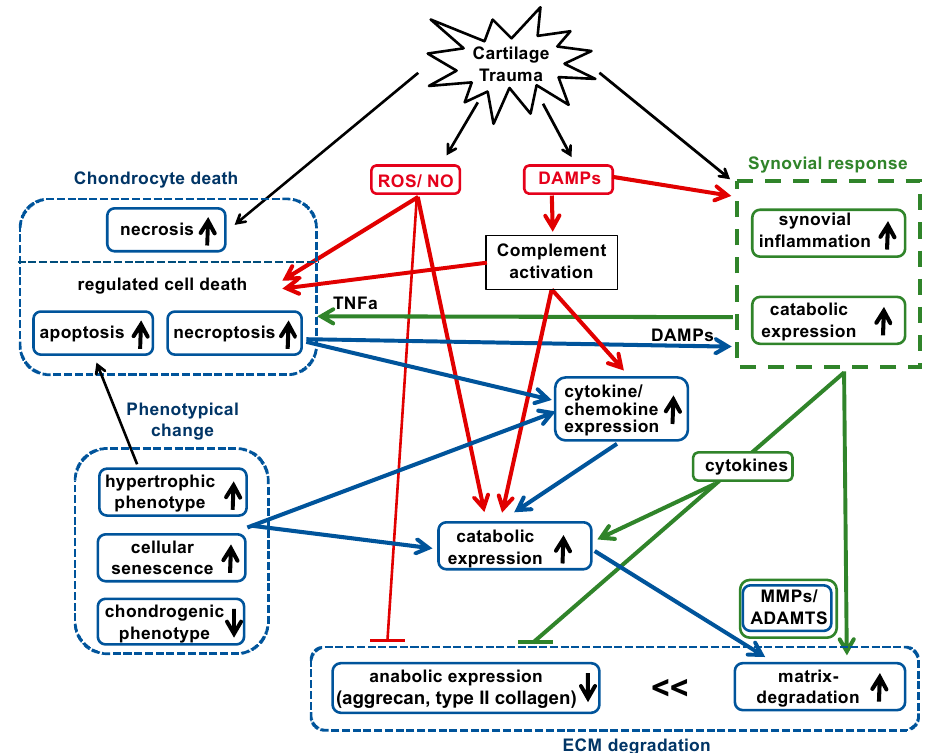
Figure 1. Cartilage trauma leads to oxidative stress and DAMP release. These mediators further trigger regulated chondrocyte death, synovial response and complement activation, which result in the production of catabolic enzymes and pro-inflammatory factors—key drivers of ECM degradation. These pathophysiologic conditions also promote phenotypical changes of the chondrocytes, comprising hypertrophy and senescence. Black lines = directly trauma-related; blue lines = chondrocytes-related; green lines = synovial cell-related; red lines = directly ROS/DAMP/complement-related.